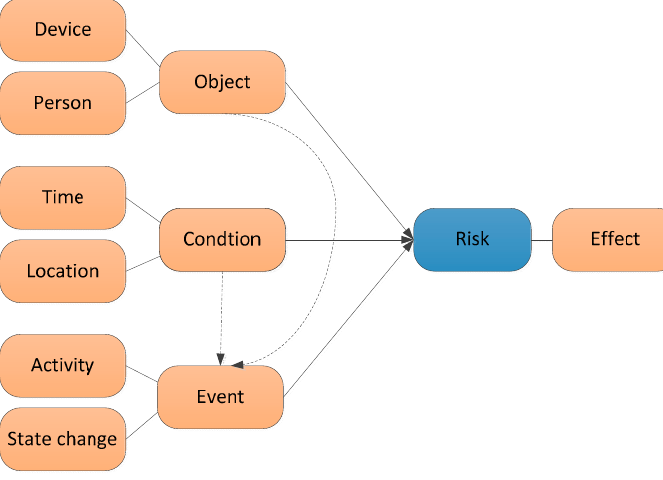
Figure 6. The concept model of risk events.